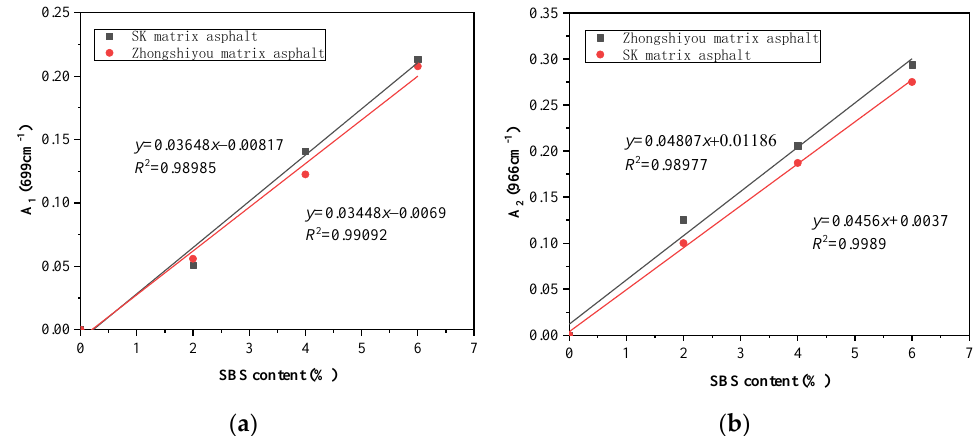
Figure 6. Standard curves of A value with SBS content at different absorbance ( a ) 699 cm −1 and ( b )